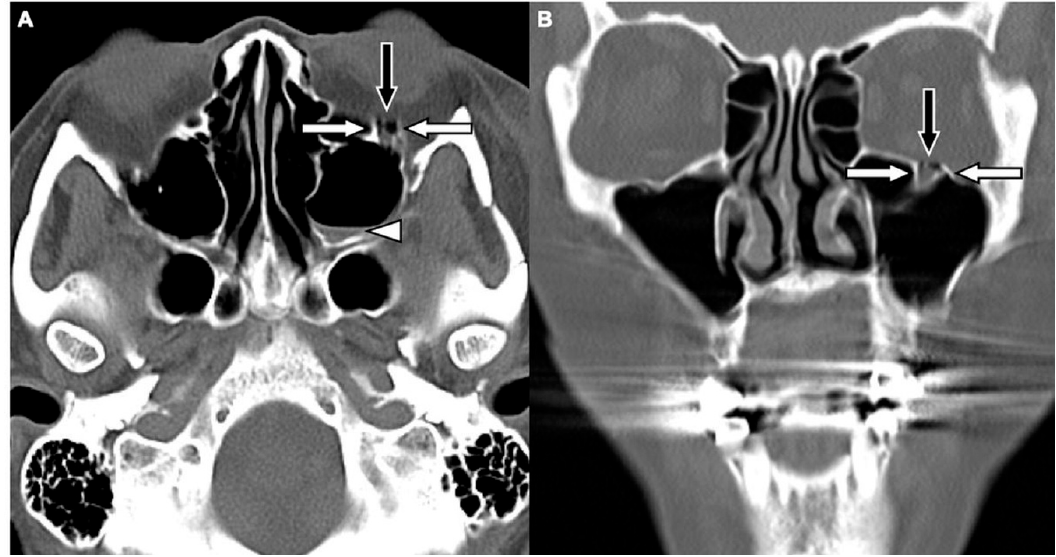
Figure 1. CT images of a 29-year-old male with assault-related head trauma and a concomitant left orbital floor fracture (OFF). An axial head CT image ( A ) and the corresponding coronal facial CT image ( B ) show gas bubbles (black arrow) entrapped between the discontinuous floor fragments (white arrows). Left type 2 maxillary hemosinus (MHS) (arrowhead) and a left zygomatic fracture are also noted in (A).